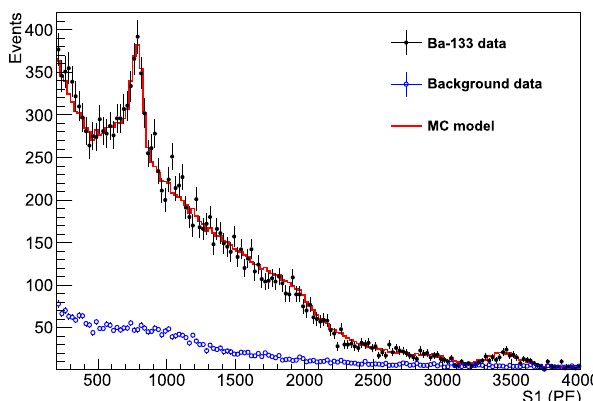
background and the best fit to a template (Monte Carlo signal + back- ground data) that accounts for detector resolution. The dotted line at 2400 PE marks the start of the fit window for the 137 Cs S1 spectrum